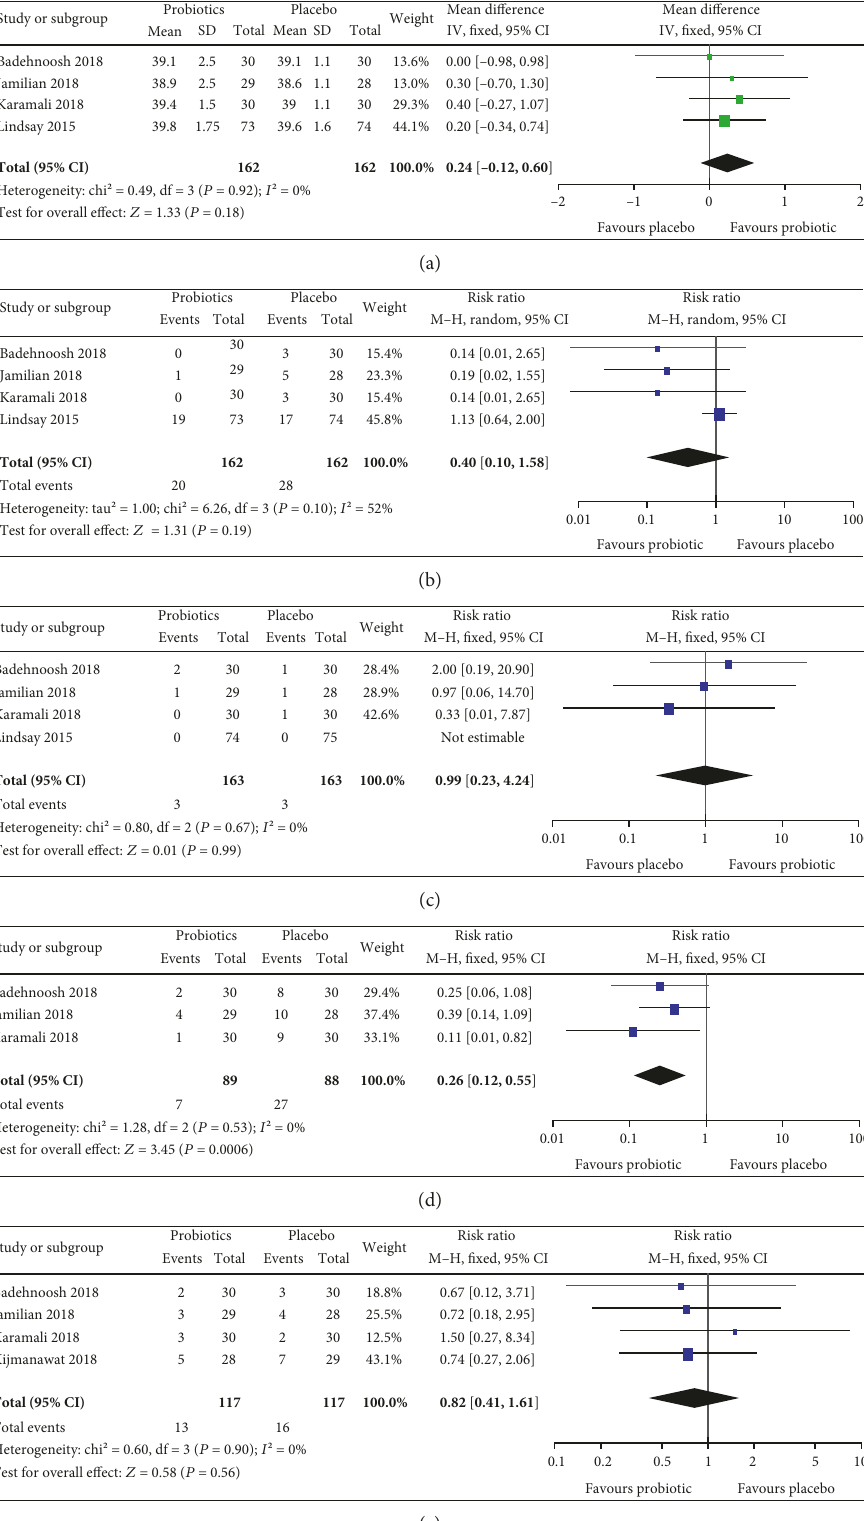
Figure 3: E ff ect of probiotic supplementation on pregnancy outcomes: (a) gestational age (weeks), (b) the incidence of macrosomia, (c) the incidence of preterm delivery, (d) the incidence of newborns ’ hyperbilirubinemia, and (e) the incidence of newborns ’ hypoglycemia in pregnant women with gestational